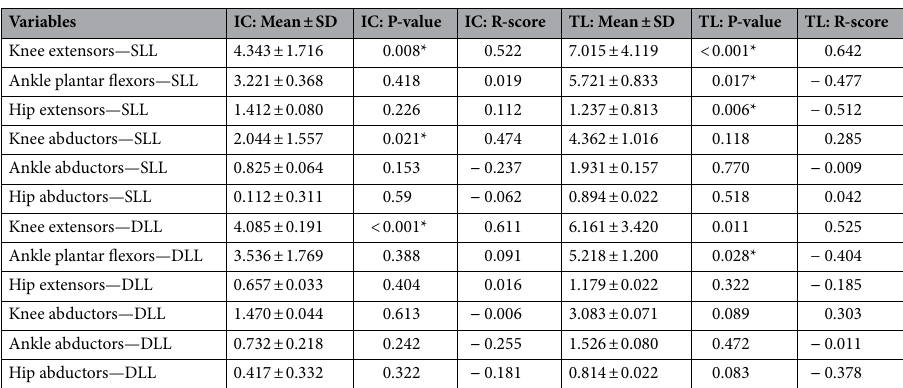
Table 2. Correlation between knee, ankle, and hip joints MEA (J/kg m) in sagittal and frontal motion planes at IC and TL phases during SLL and DLL and DKV angle during SLL (− 9.35° ± 3.74°) and DLL (− 5.64° ± 3.28°)/* = Significant variables/negative R-score = inverse correlation, positive R-score = positive correlation.